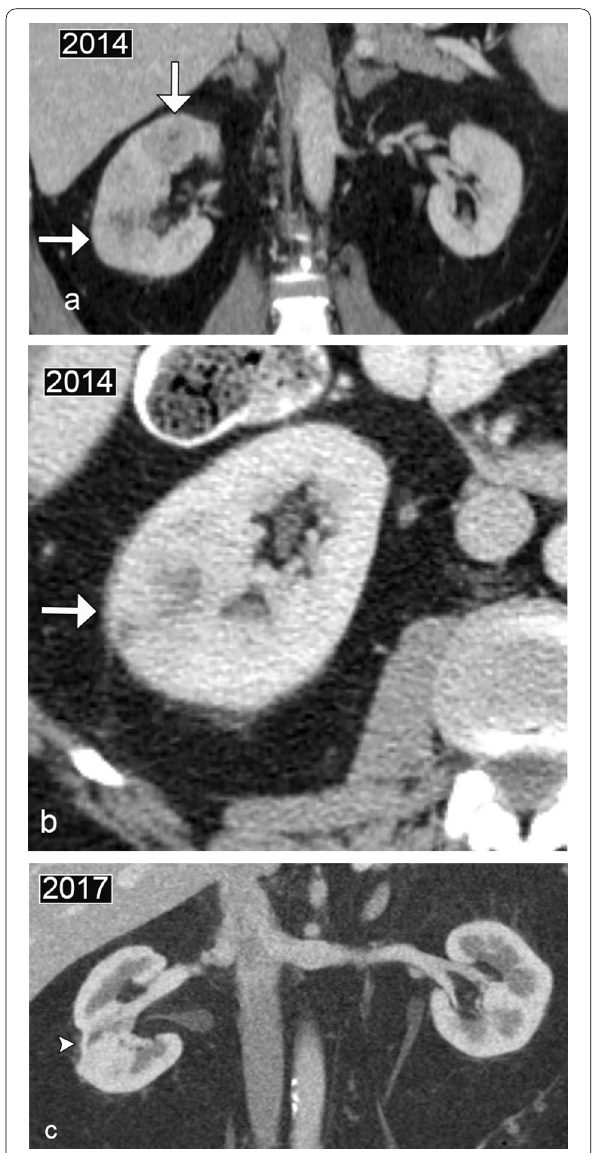
Fig. 10 Pyelonephritis and renal abscesses. Coronal ( a ) and axial ( b ) contrast CT images in 2014 of the abdomen demonstrate a delayed right nephrogram with cortical heterogeneity. Suggestion of mass-like areas in the right kidney with perinephric stranding (arrows) identified, mimicking the multiple masses of renal lymphoma. This was presumed to be related to pyelonephritis with renal abscesses based on clinical presentation. Follow-up coronal contrast CT in 2017 ( c ) demonstrates focal parenchymal scarring in the region of the right lower pole mass as a result of prior infection (arrowhead)